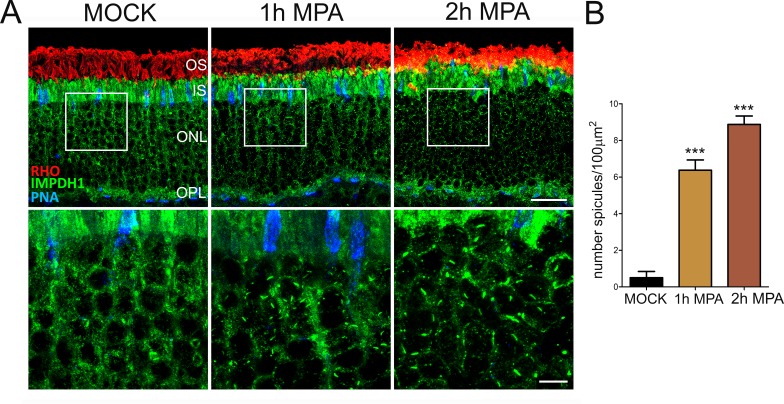
Formation of IMPDH1 spicules in intact retinas in response to mycophenolic acid-treatment.(A) Murine retinal sections from dark-adapted mock- or 10 μM MPA-treated retinas for 1 or 2 hr. MPA inhibition of IMPDH1 resulted in the formation and accumulation of IMPDH1 spicules with time, particularly noticeable at the perinuclear region of photoreceptor cells (8.5x Zoom images) at the outer nuclear layer. IMPDH1 immunolocalization shown in green; PNA staining of cones in cyan. Confocal images are the average z-projections of three optical slices acquired with a step size of 0,13 μm. (B) Histogram showing the number of spicules/100 μm2. (Mock vs 1 h MPA, p=0.0001; MOCK vs 2 h MPA p<0.0001), with at least 6 planes from 2 animals analyzed per condition. OS: outer segment, IS: inner segment, ONL: outer nuclear layer, OPL: outer plexiform layer. Scale bar upper panels (20 μm) and bottom panels (5 μm).